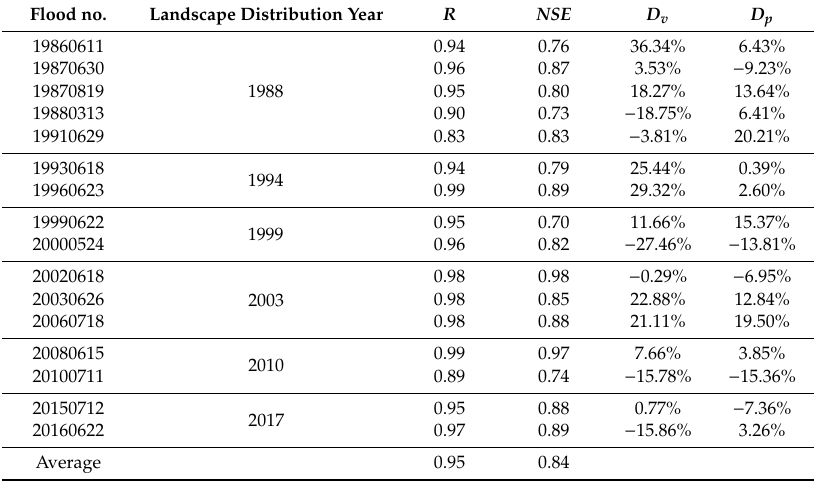
Table 2. Summary of validation results for flood simulation at daily step. Flood